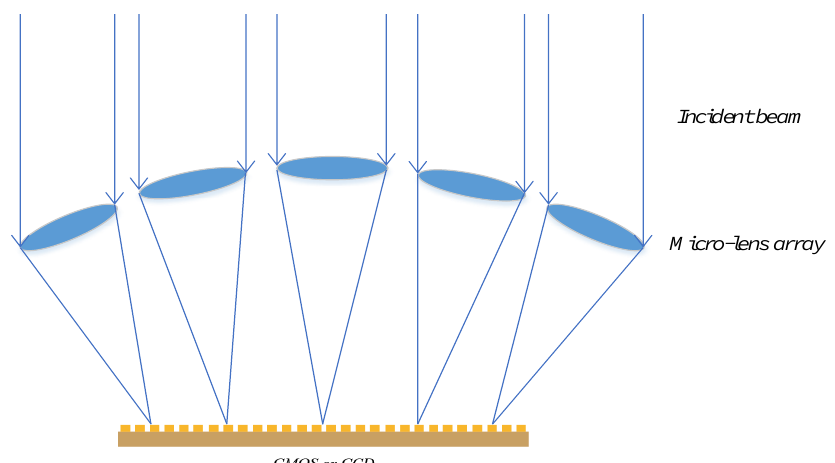
Figure 6. Surface microlens direct imaging scheme.